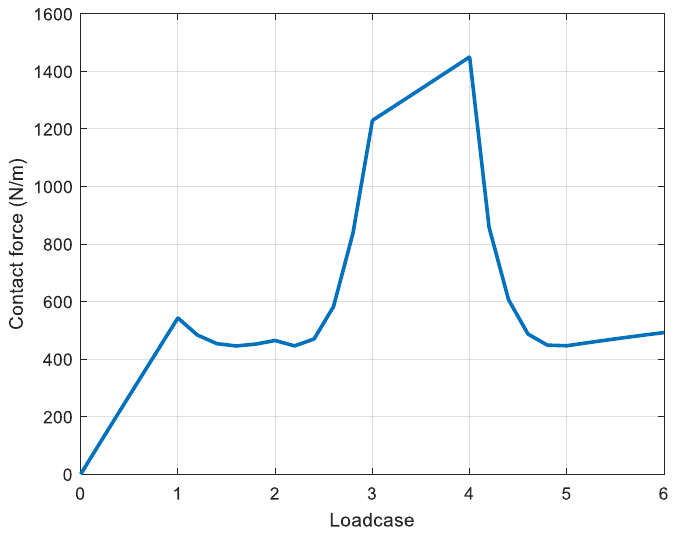
Figure 25. Contact force per meter span at the sliding contact for the load cases given in Table 4 computed with the FE model described in Section 4.2.